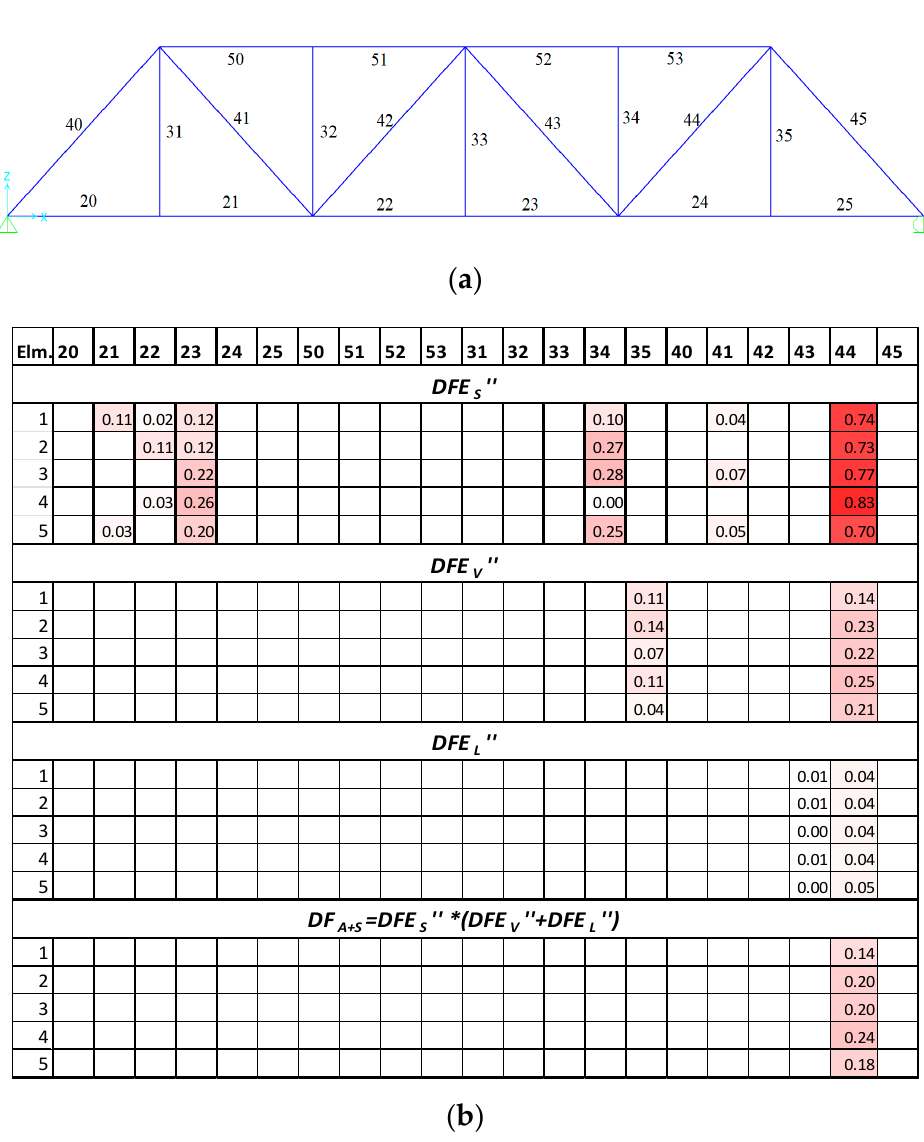
Figure 11. ( a ) The actual location of damage for damage case-3, ( b ) Identified damage using the proposed framework for damage case-3.